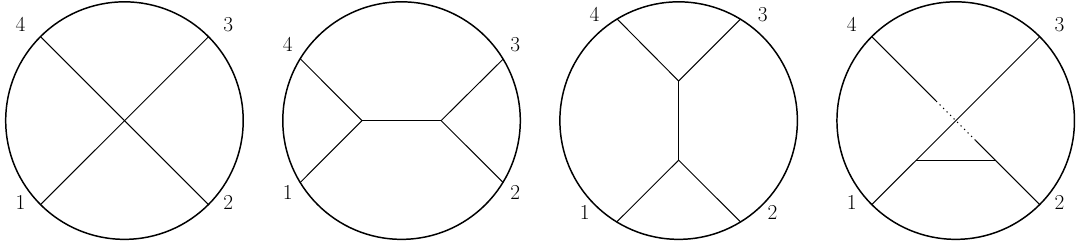
Figure 3 . Witten diagrams contributing to the four-point function at tree